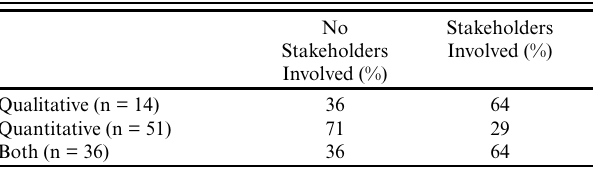
Table 3 . Stakeholder inclusion by type of approach (qualitative vs.